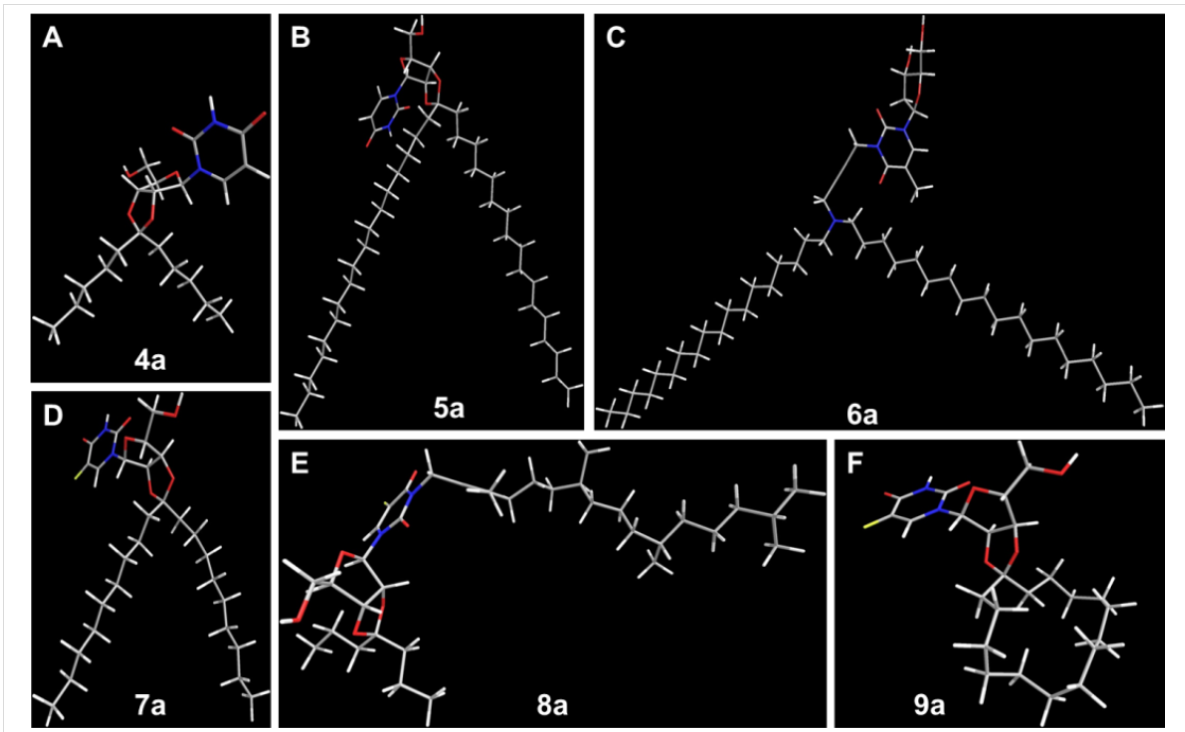
Figure 3: Energy-minimized 3D structures of the lipophilic nucleoside headgroups 4a – 9a . All 3D structures were calculated using the program ChemBio3D Ultra v. 12.0 (number of iterations, 387 ± 147, standard deviation of the mean).